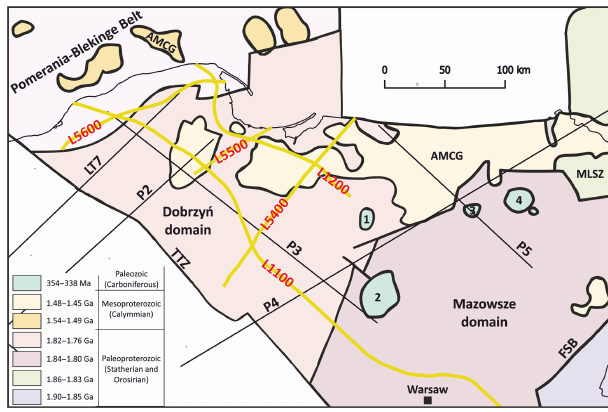
Figure 2. Location of the PolandSPAN ™ seismic profiles (yellow lines) on the background of a simplified geological map of the East European Craton crystalline basement units (after Krzemi´nska